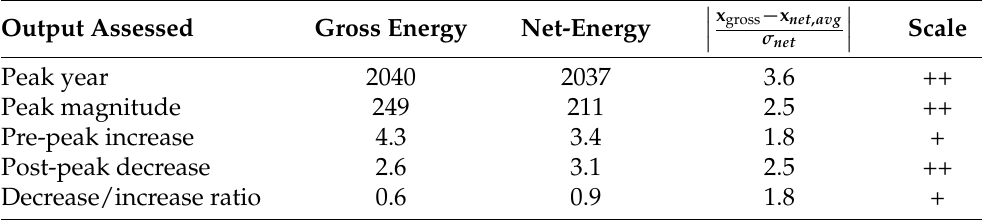
Table 8. Comparison between gross and net-energy outputs to estimate the robustness of the